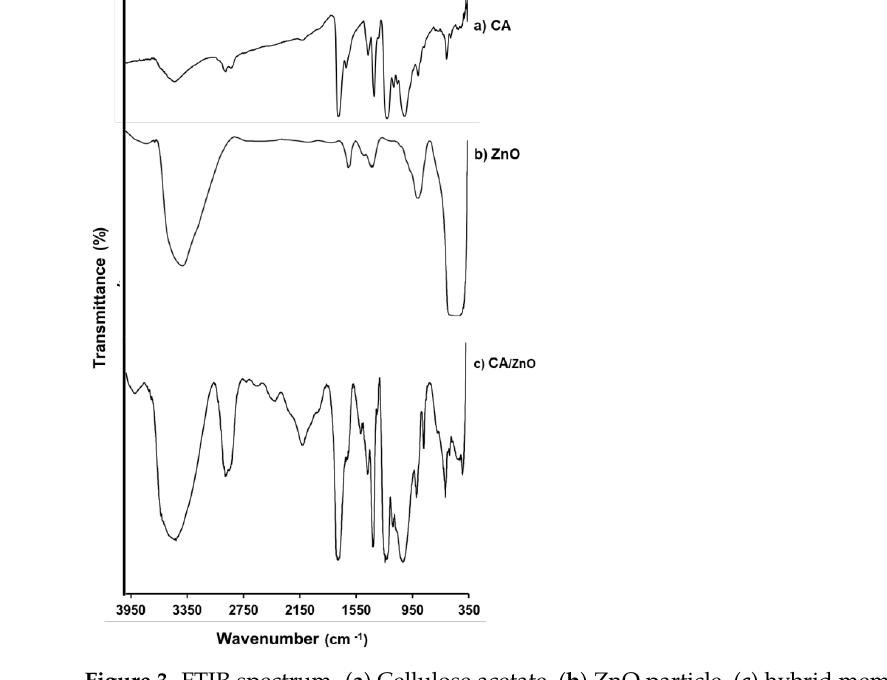
Figure 3. FTIR spectrum. ( a ) Cellulose acetate, ( b ) ZnO particle, ( c ) hybrid membrane of cellulose acetate and ZnO particles.